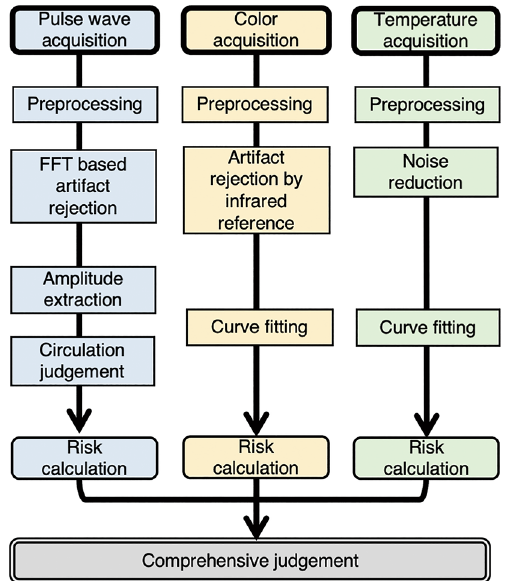
Figure 3. Flow chart of the algorithm for sensor-based assessment of tissue circulation. The pulse wave signal is analysed using a fast Fourier transform (FFT) to estimate fluctuations in capillary blood volume in real time. The colour and temperature signals are analysed by curve fitting to estimate the change in these parameters in the event that circulation is compromised. The risk rates are independently calculated using the algorithm described in Supplementary Fig. 2 and integrated to provide a comprehensive